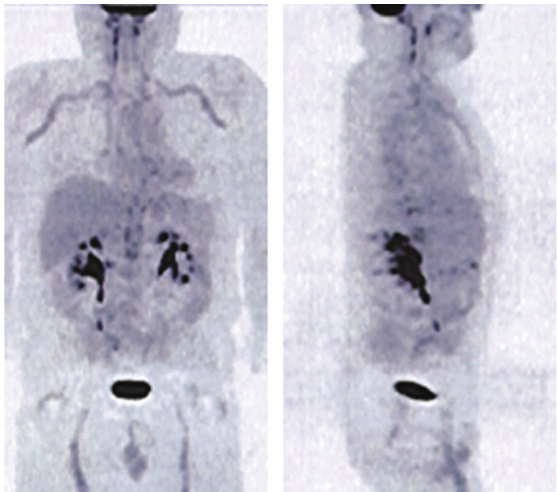
Figure 1: PET scan showing increased uptake of 18F-FDG at the subclavian, carotid, humeral, vertebral, and femoral arteries and less intensively at the ascending and descending aorta, a pattern suggestive of TA. PET: positron emission tomography. 18F-FDG: 18F-fluorodeoxyglucose. TA: Takayasu